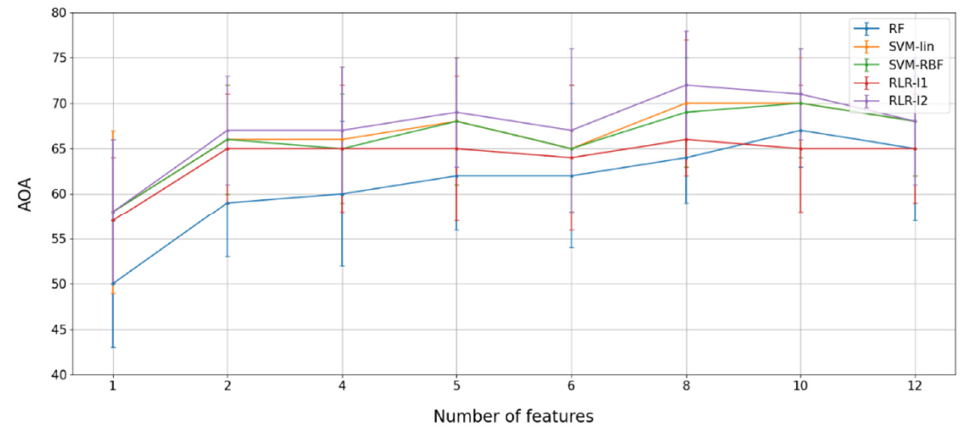
Figure 12. Average Overall Accuracy (±standard deviations) returned by the different algorithms according to the number of selected features.